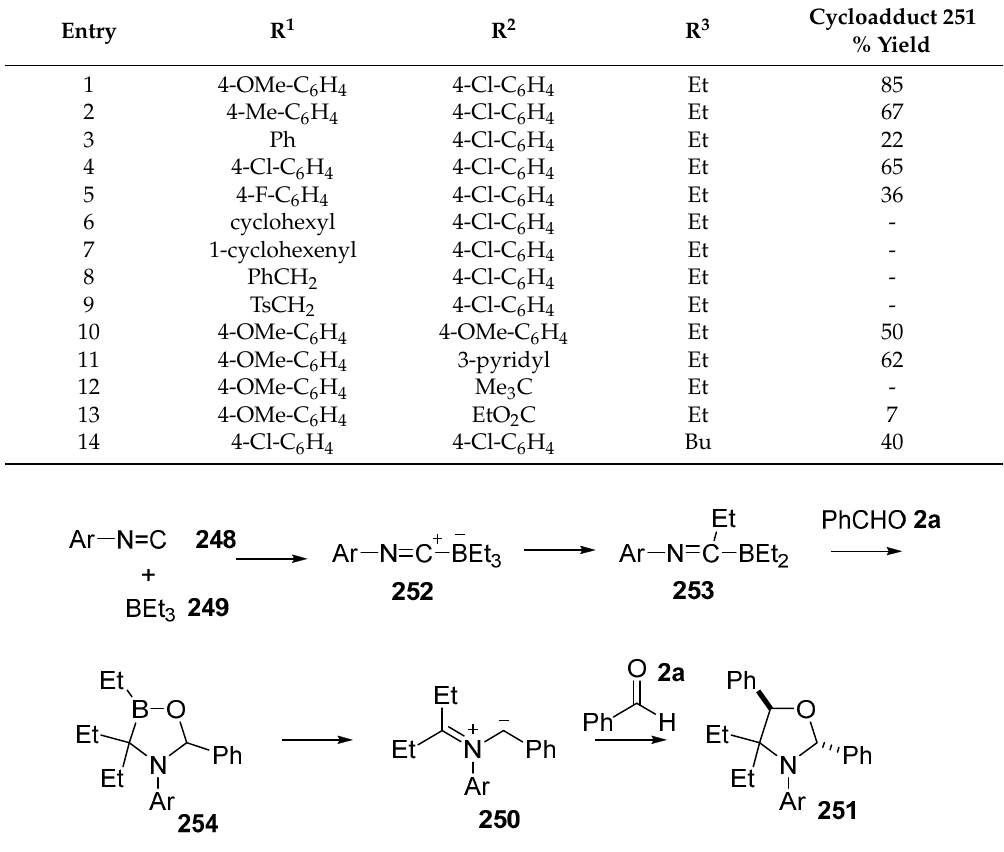
(Scheme 73). Table 35. Multicomponent reaction of aldehydes 2 , isocyanides 248 and trialkylboron reagents 249 (Scheme